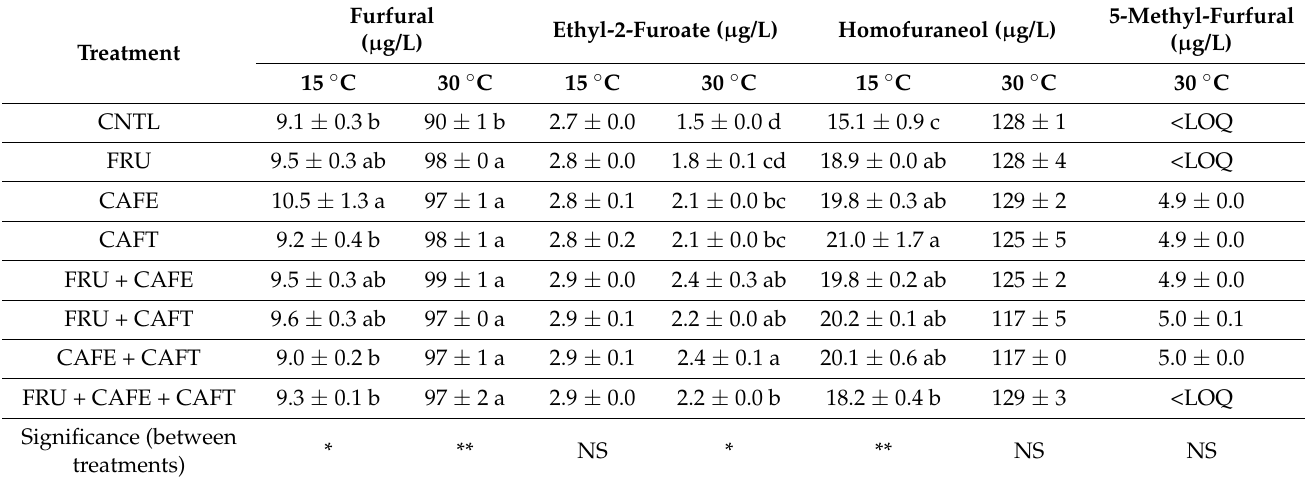
Table 2. Furan derivatives determined by Headspace Solid Phase Micro-Extraction-Gas-Chromato- graphy/Mass Spectrometry (HS-SPME-GC/MS) in base wines after 90 days of temperature- controlled storage.